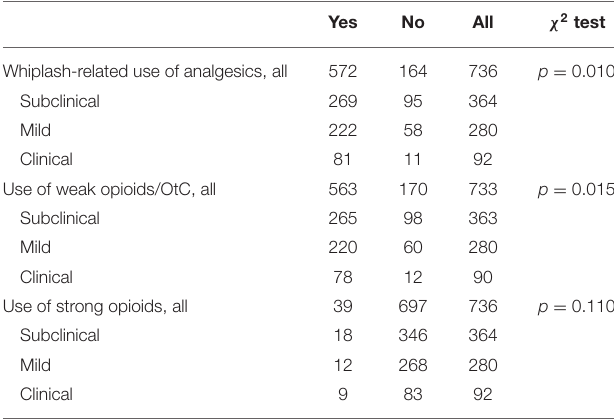
TABLE 2 | Use of analgesics at baseline for the overall sample and the three PTSS